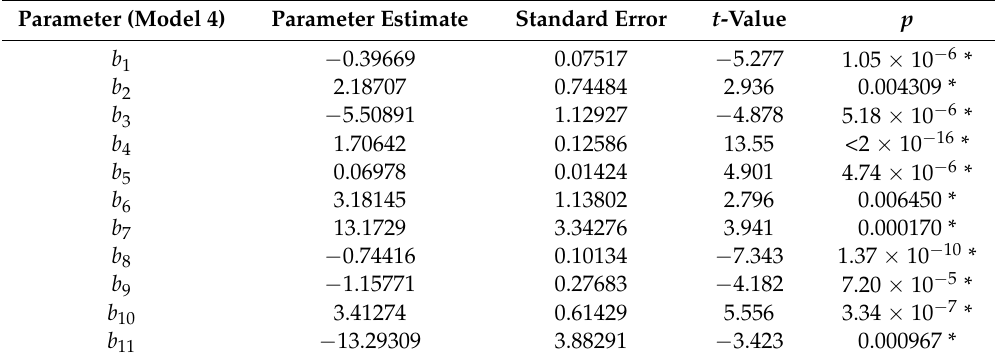
Table 7. Results of the OLS regression of Model 4 on the test data